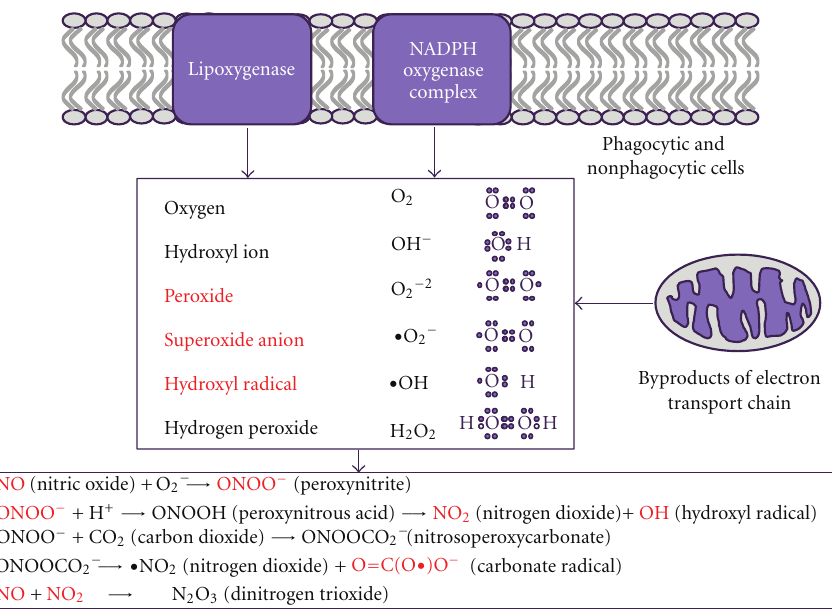
Figure 1: Reactive oxygen species: main forms and sources. Reactive oxygen species occur mainly as byproducts of the mitochondrial respiratory chain but can also originate from the activities of NADPH and lipoxygenase. Once released, reactive oxygen species can react with NO leading to the generation of reactive nitrogen species. Molecules with unpaired electron free radicals are shown in